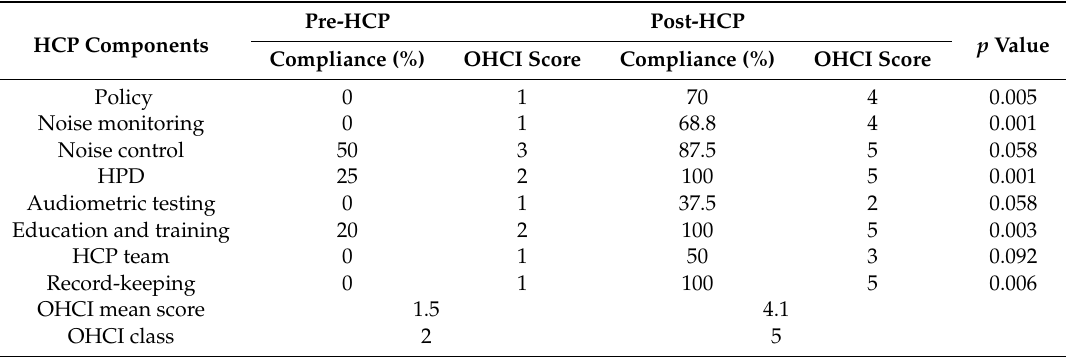
Table 3. Result of pre-HCP and post-HCP OHCI